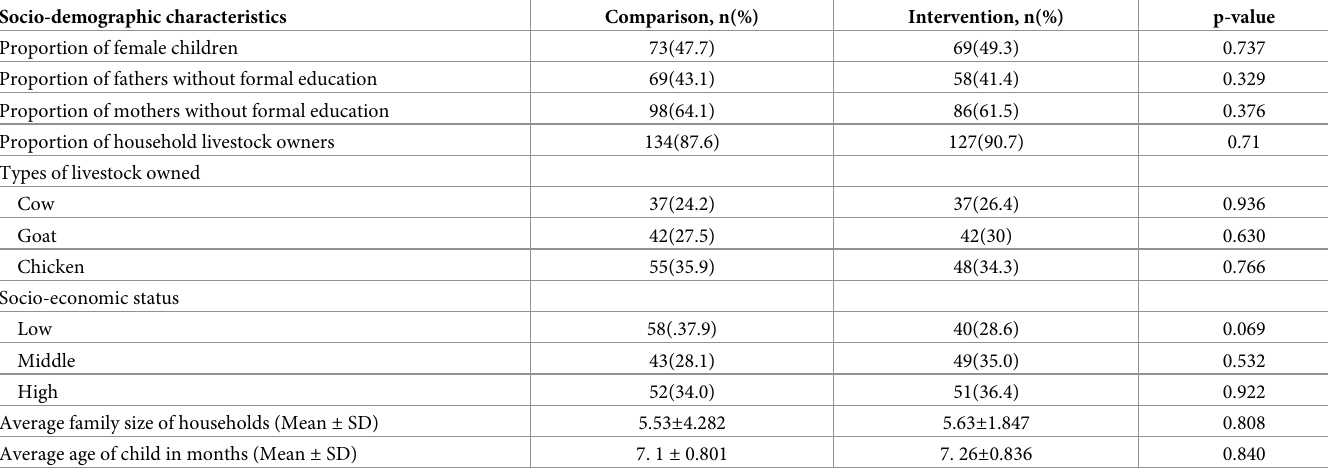
Table 3. Socio-demographic and economic characteristics of participants at baseline in rural districts of Tigray, Ethiopia (N = 293). Socio-demographic characteristics